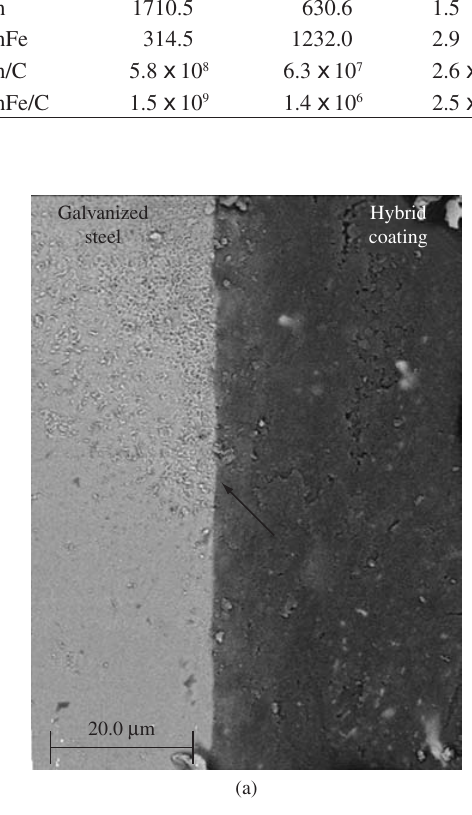
Figure 8. a) SEM micrographs of the cross section of Zn/C; and b)